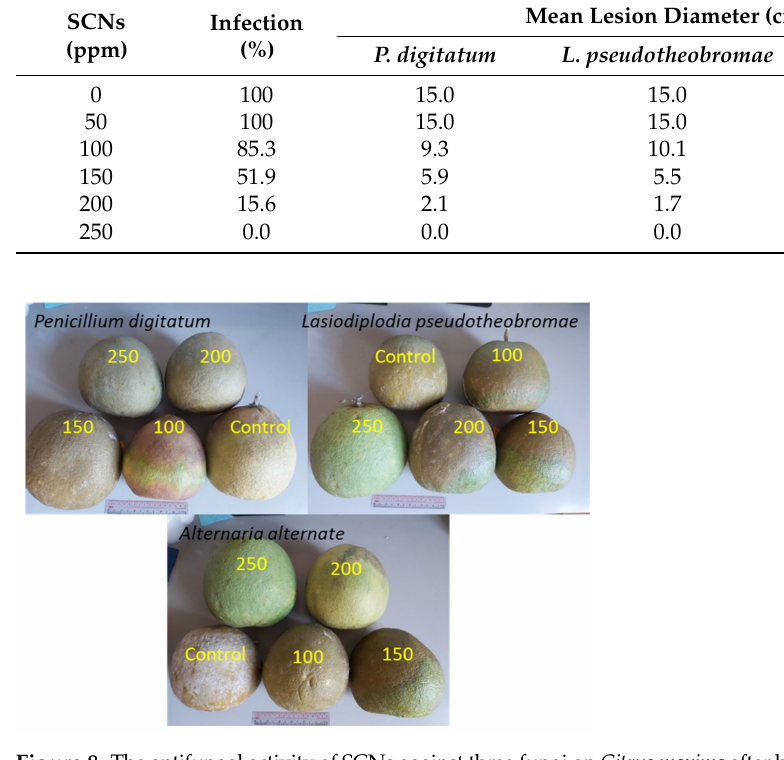
Figure 8. The antifungal activity of SCNs against three fungi on Citrus maxima after being treated for a week. The antifungal activity of SCNs against P. digitatum , L. pseudotheobromae, and A. alternate caused the decay on Citrus reticulata × sinensis fruits as presented in Table 2 and Figure 9.